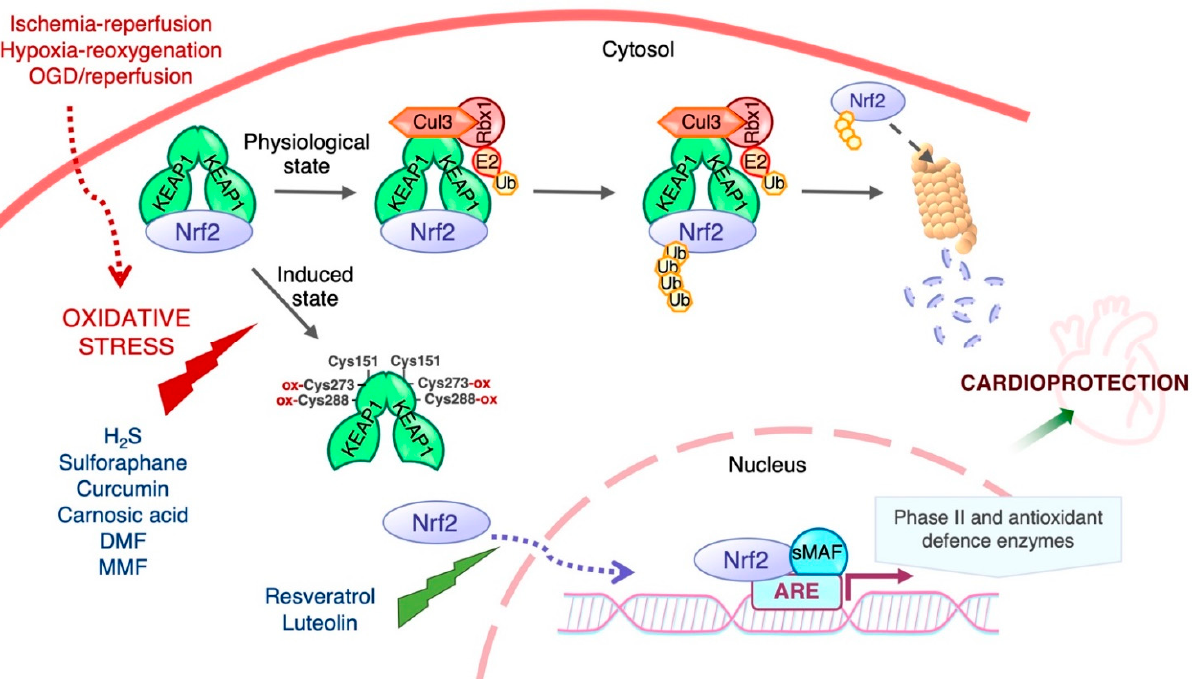
Figure 2. Regulation of Nrf2 transcriptional activity by Keap1. Nrf2 activity and hence the expression of its target genes is maintained at low levels by Keap1 under normal homeostatic conditions, but increases rapidly in response to redox and electrophilic stressors as well as by stimulation by growth factors. Cys151 is required for triggering Nrf2 signaling by activating agents, and Cys273 and Cys288 are functionally important for the sensing of inducers [56]. The biological effects of Nrf2 are exerted through its ability to mediate the induction of genes containing an antioxidant response element (ARE) in their promoter region upon exposure to a broad spectrum of oxidants and eletrophiles.